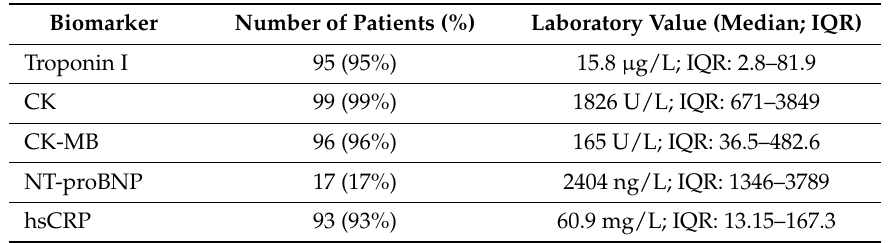
Table 4. Admission biomarkers of our anterior ST-segment elevation myocardial infarction patients (total number, n = 100).